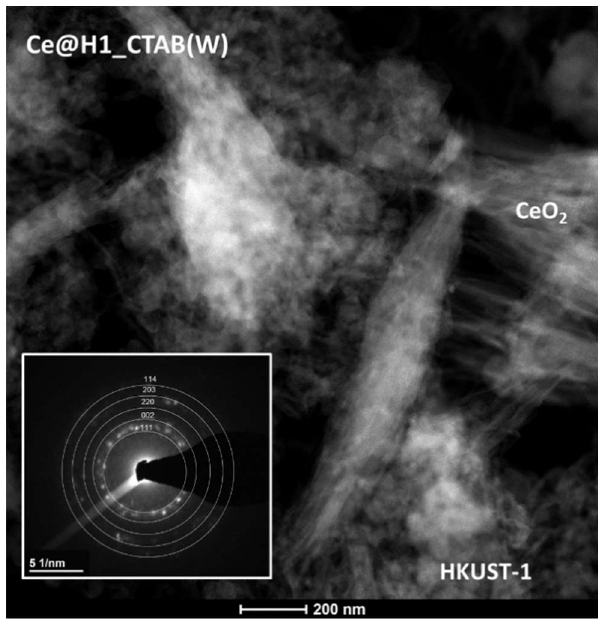
Figure 6. HAADF-STEM image of Ce@H1_CTAB(W) with SAED electron diffraction of CeO 2 phase.